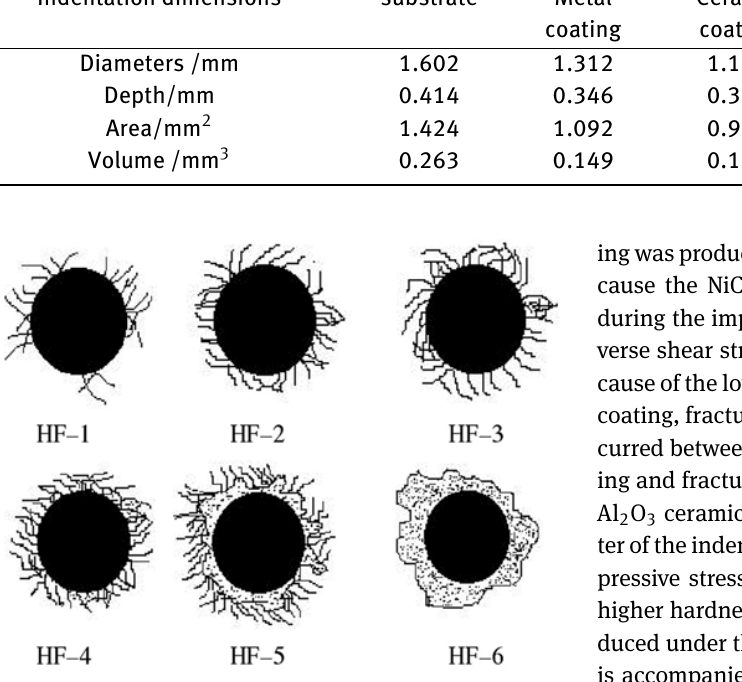
Figure 5: Quality standard for bond strength by indentation